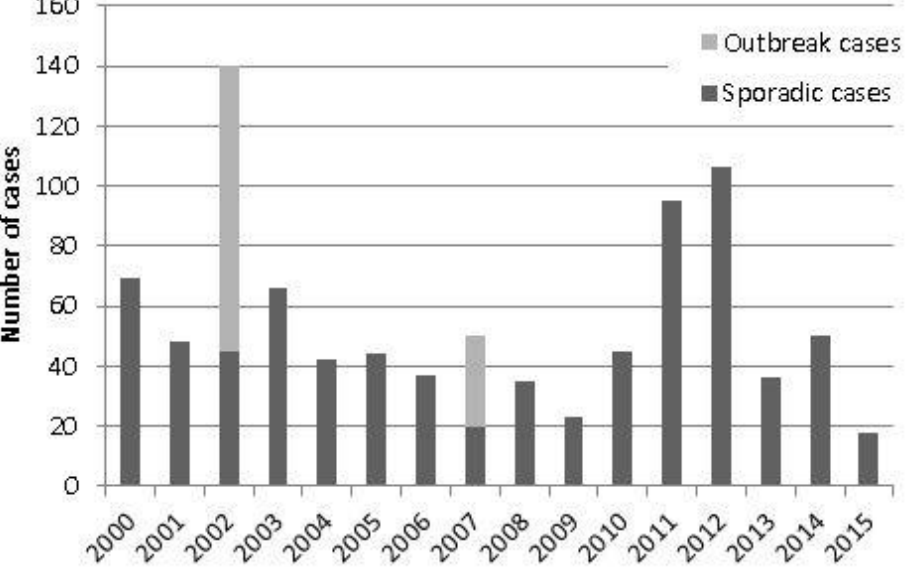
Figure 1. Acute Q fever diagnoses in England and Wales, 2000–2015, by outbreak or sporadic.